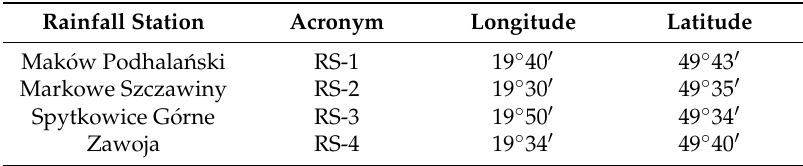
Table 2. Rainfall stations located nearby the study